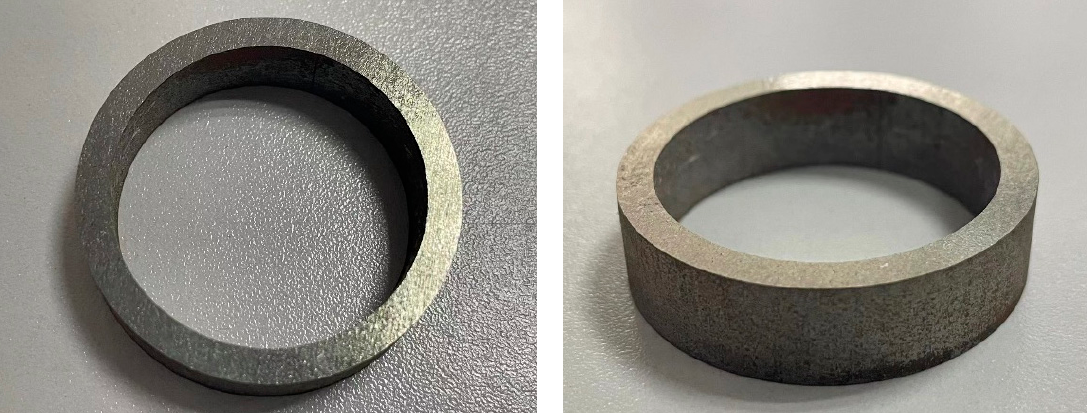
Figure 16. Ring test specimen machined by